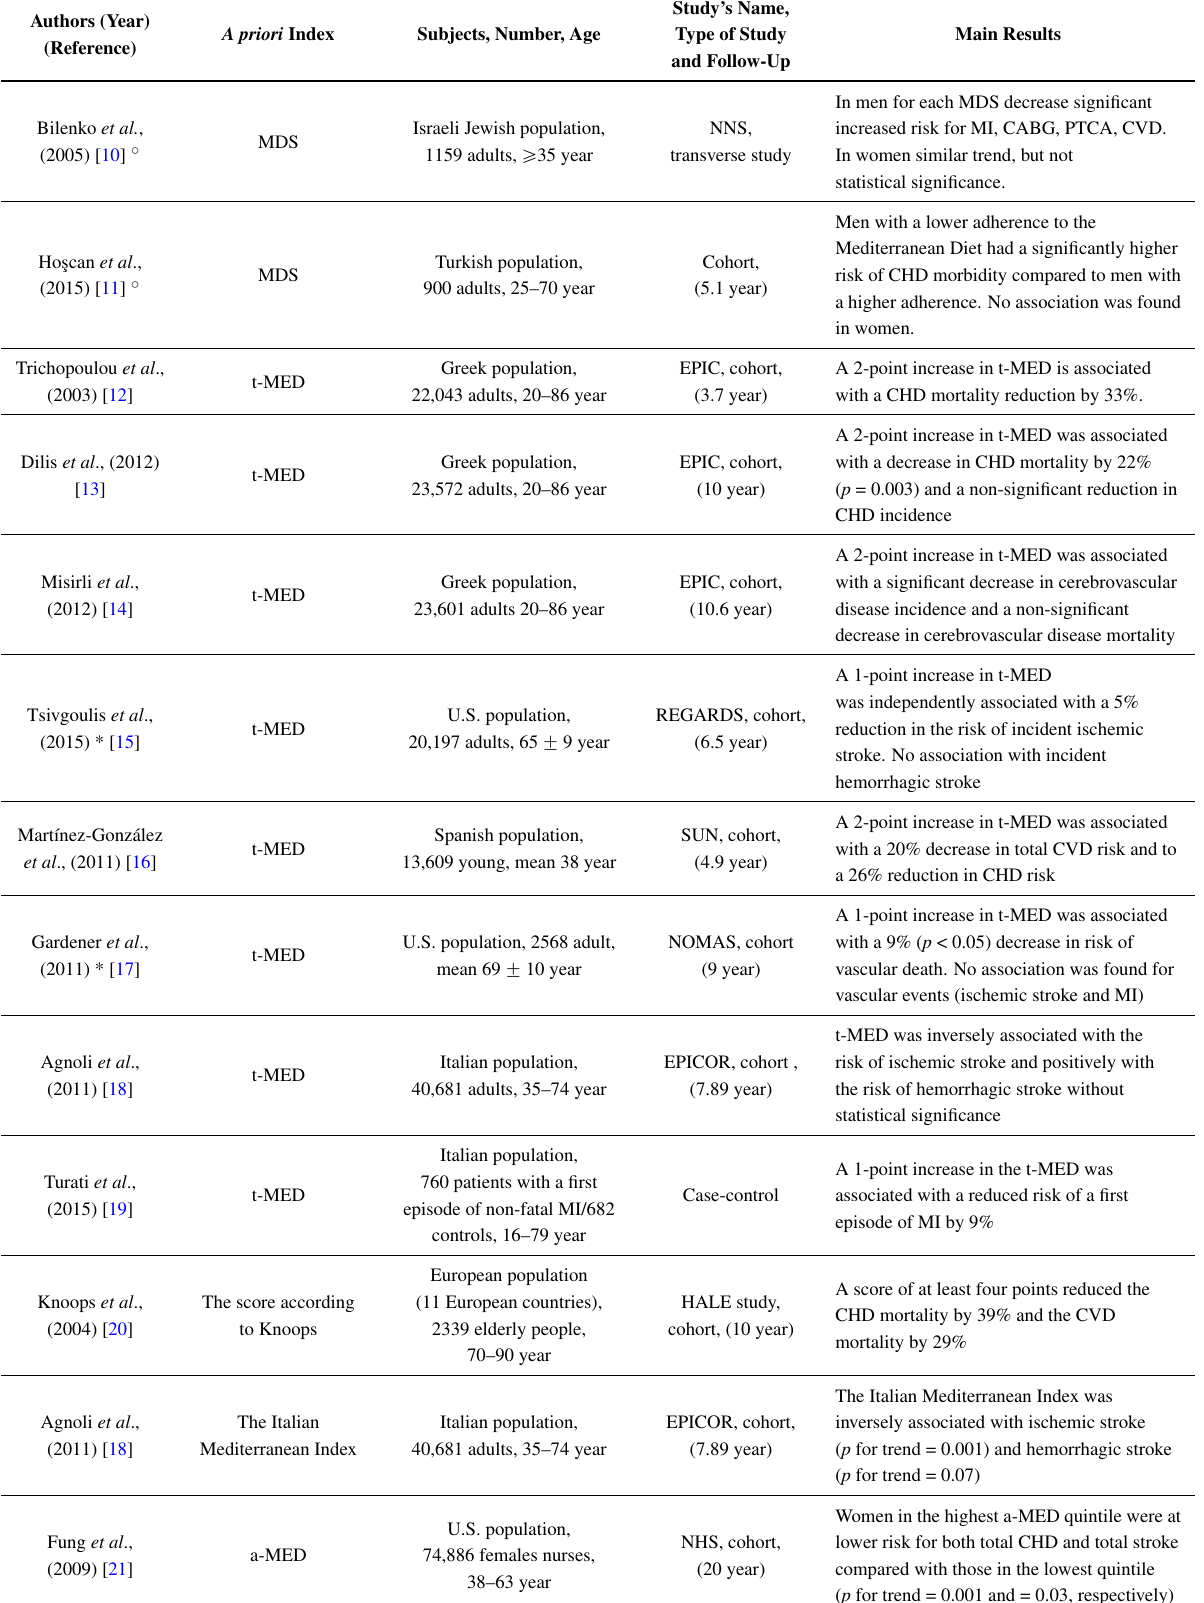
Table 1. A priori dietary indexes and main results of the studies that evaluated the relationship between the Mediterranean Diet and CVD, CHD and cerebrovascular